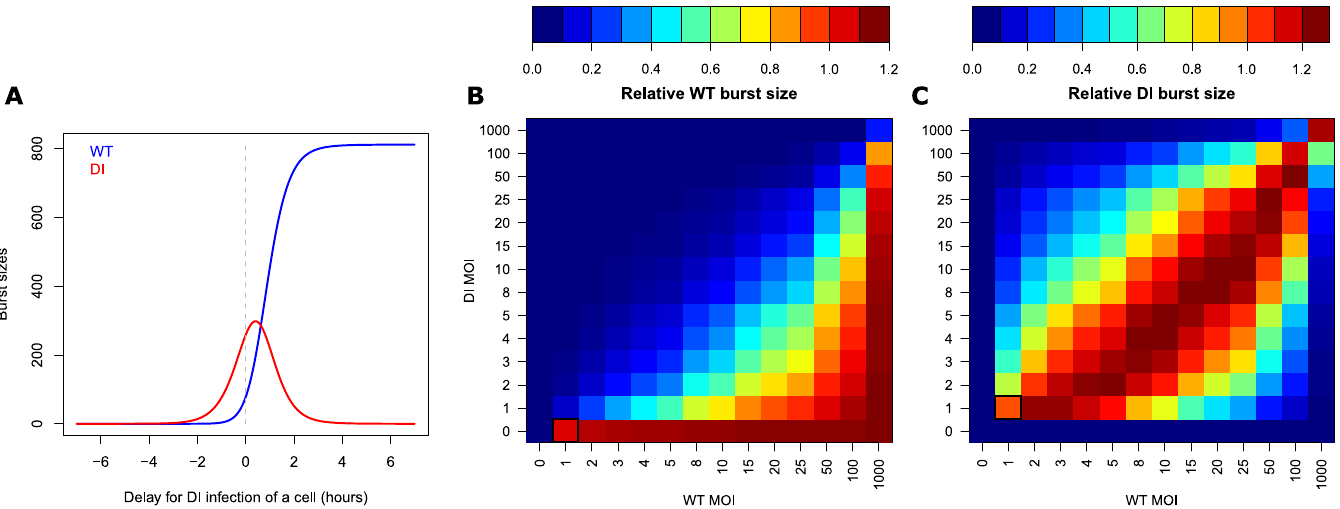
Fig 6. Model-predicted impact of infection delay and initial multiplicity of infection (MOI) on WT and DI burst sizes. A: WT (blue) and DI (red) predicted burst sizes (encapsidated genomes at 9 hours post infection) for various delays in DI infection of a cell. Negative delays correspond to cases where DI infects first and positive delays to cases where WT infects first. The dashed gray line marks the case of simultaneous infection by WT and DI. B-C: Heat maps representing the predicted relative burst sizes of (B) WT, B , and (C) DI, B , as a function of initial WT (x-axis) and DI (y-axis) MOIs (input). WT burst sizes were normalized by WT burst size resulting WT DI from WT:DI = 1:0 MOIs and DI burst sizes by DI burst size resulting from WT:DI = 1:1 MOIs (black